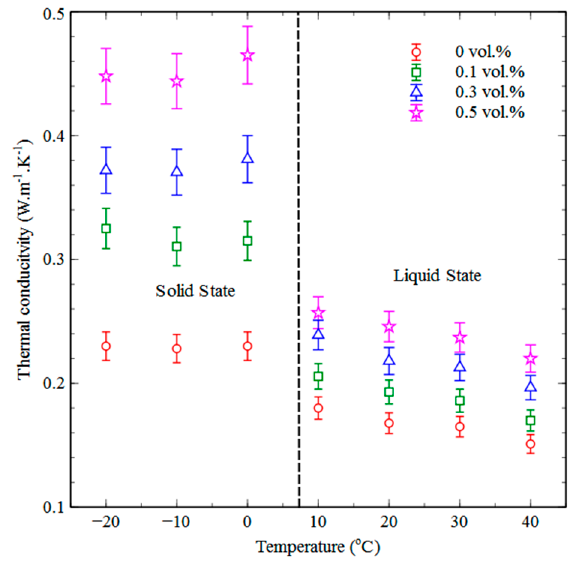
Figure 4. E ff ect of functionalized GnP loading and temperature on the thermal conductivity of the PCM nanocomposites.